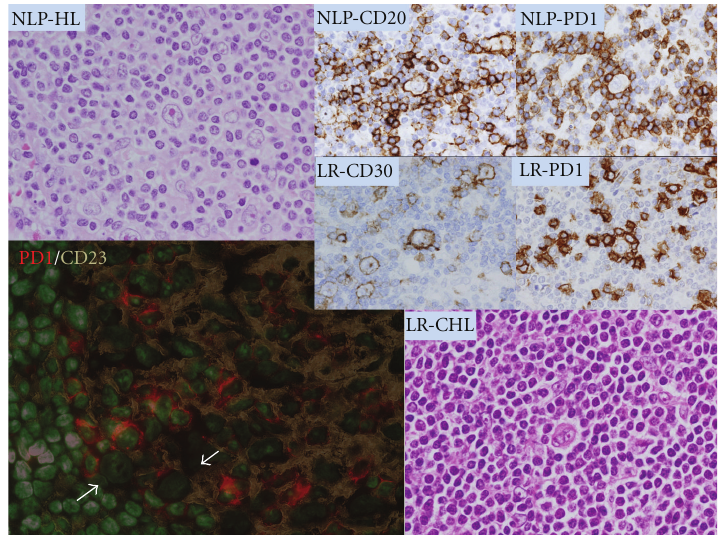
Figure 1: NLP-HL: HE section of a case of Nodular lymphocyte-predominant Hodgkin lymphoma, showing a typical lymphocyte- Predominant (LP) cell positive for CD20 (NLP-CD20) and surrounded by a rim of PD1-positive T cells (NLP-PD1). LR-CHL: HE section of a case of lymphocyte-Rich Classical Hodgkin lymphoma that highlights a typical Reed-Sternberg (R-S) cell with the characteristic phenotype (CD30+, LR-CD30) and surrounded by a rim of PD1-positive T cells (LR-PD1). The pattern is reminiscent of that found in the outer part of the germinal centre where PD1-positive cells surround large B blasts (see arrows in the immunofluorescence capture region of the outer zone of a reactive germinal centre).